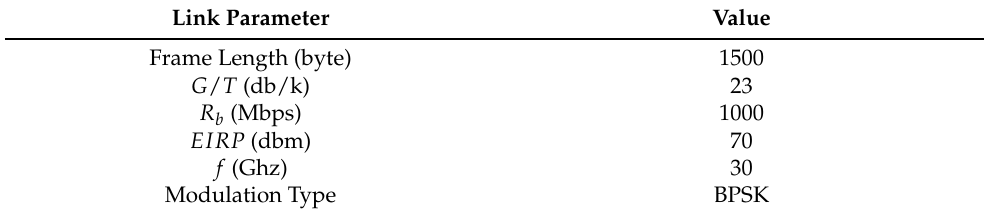
Table 8. Link parameters and corresponding